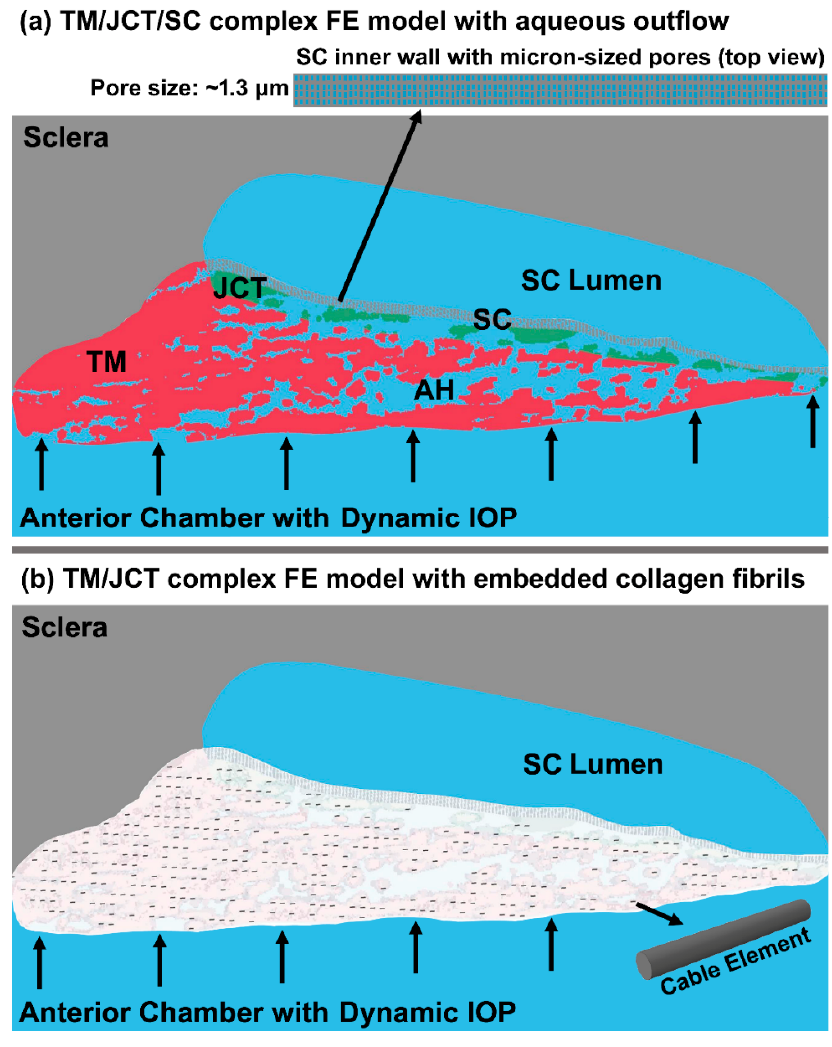
Figure 1. ( a ) The 3D microstructural FE model of the TM/JCT/SC complex and aqueous humor with ( b ) embedded elastic cable elements [60].